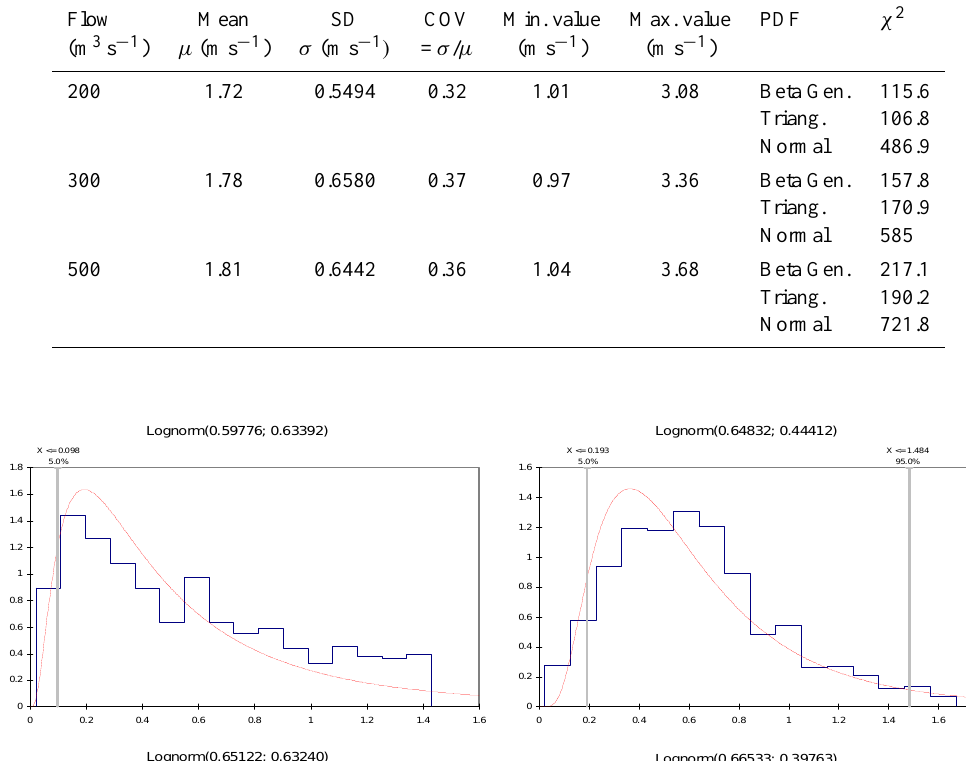
Table 5. Uniform flow model. Adaptation of PDFs to velocity with uniform distributions for n i (1000 simulations).